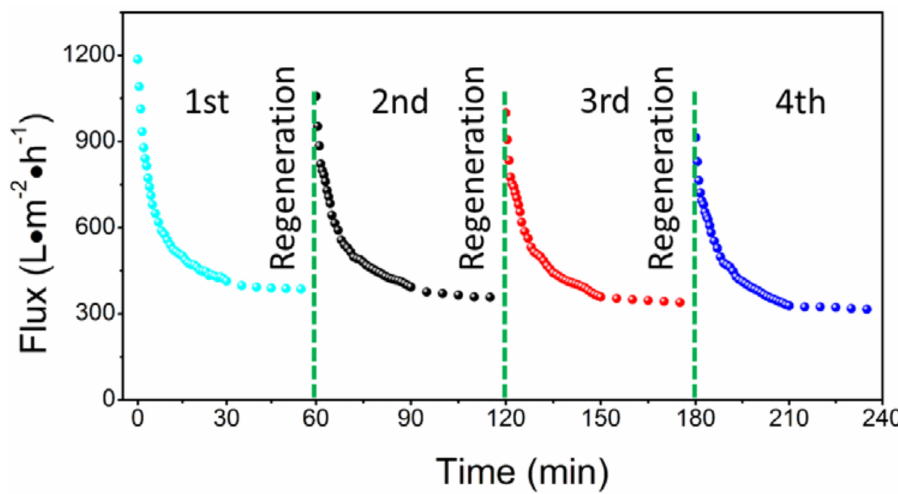
Figure 11. Variation of permeation flux with time during the filtration process (S1350-1650 membrane, 0.1 MPa, 2.5 L/min) of an oil-in-water emulsion when membrane regeneration succeeded via a simple ultrasonic agitation method applied four